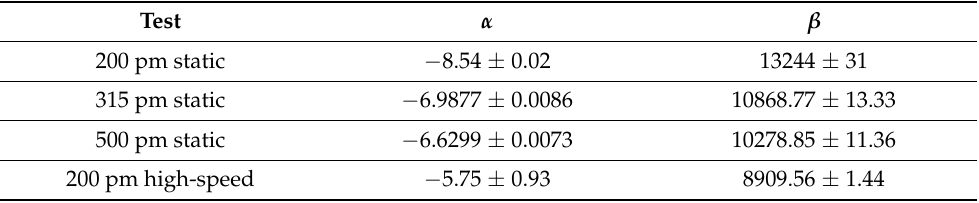
Table 1. α and β calculation during static and dynamic